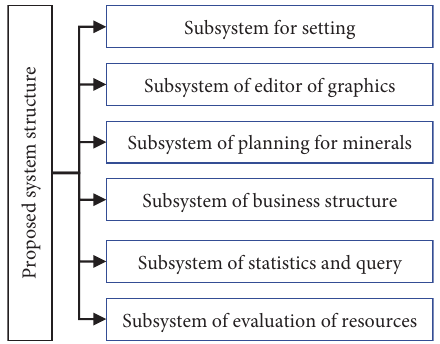
Figure 1: Proposed function of the system